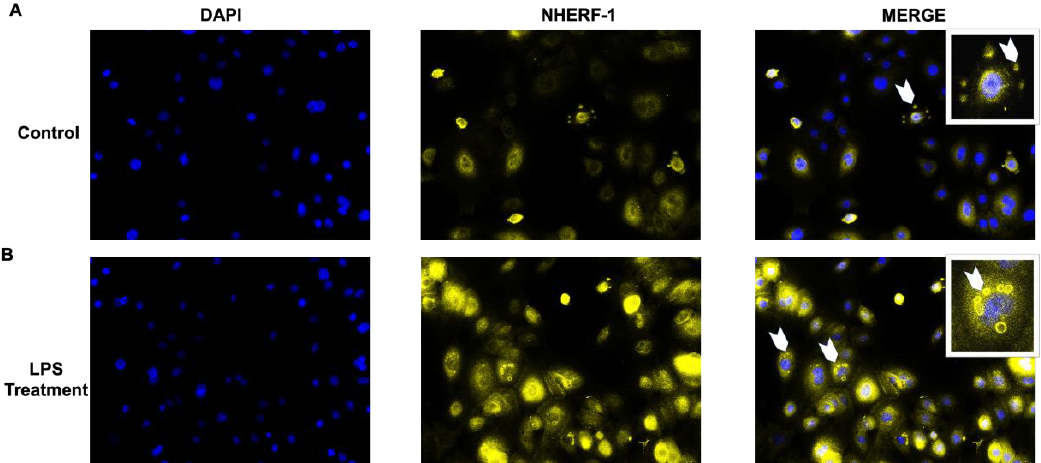
Figure 5. Translocation of NHERF1 upon LPS stimulation in AECs. AECs were exposed to ( A ) vehicle or ( B ) LPS (100 ng/mL) for 15 min, washed, and stained for NHERF1 expression ( yellow ) using immunofluorescence (IF). 4,6-diamidino-2-phenylindole (DAPI; blue ) staining was performed to detect the nucleus. Representative images are shown. Scale bar = 10 µm. Fluorescent images were collected with an Olympus BX43 fluorescence microscope at 40× magnification. The inset image is of an enlarged area marked by white arrows showing special organelle translocation towards the nucleus to LPS stimulation.